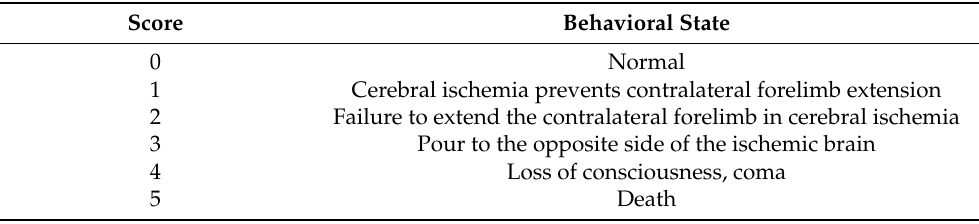
Table 1. Neurological score of rats.